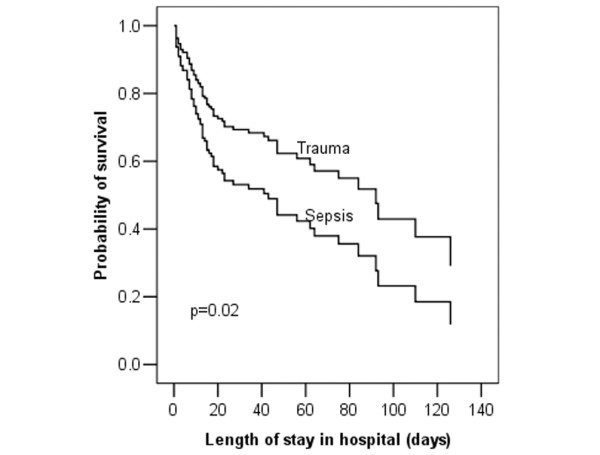
In-hospital mortality, controlling for age. The Cox survival analysis shows that patients with sepsis had higher in-hospital mortality than did trauma patients, after controlling for age.